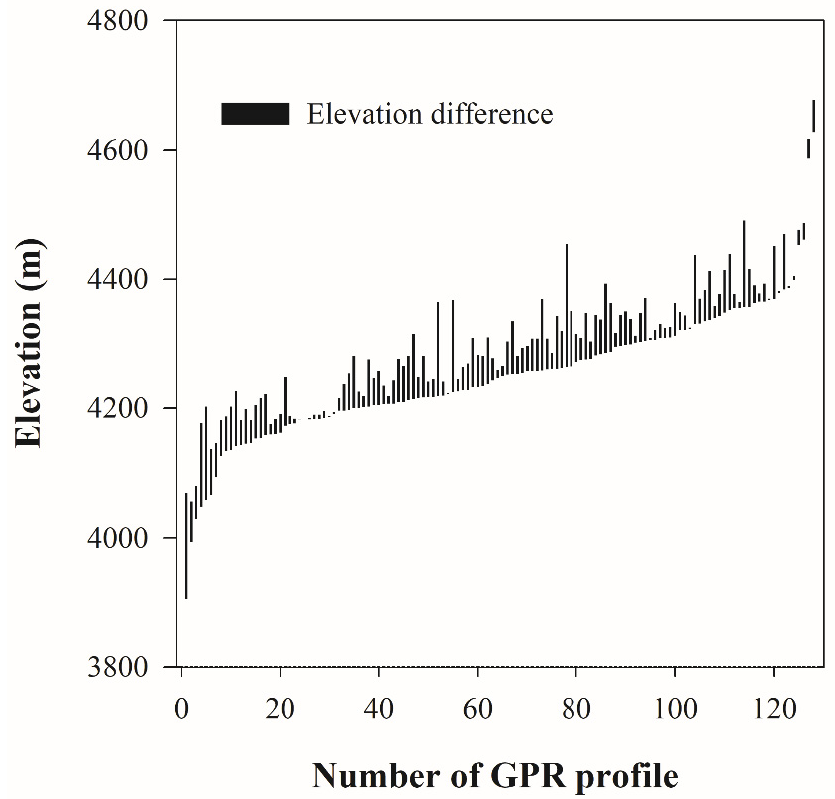
Figure 3. The elevation ranges of ground-penetrating radar (GPR) profiles (arranged by the minimum altitude of each survey profile from low to high).